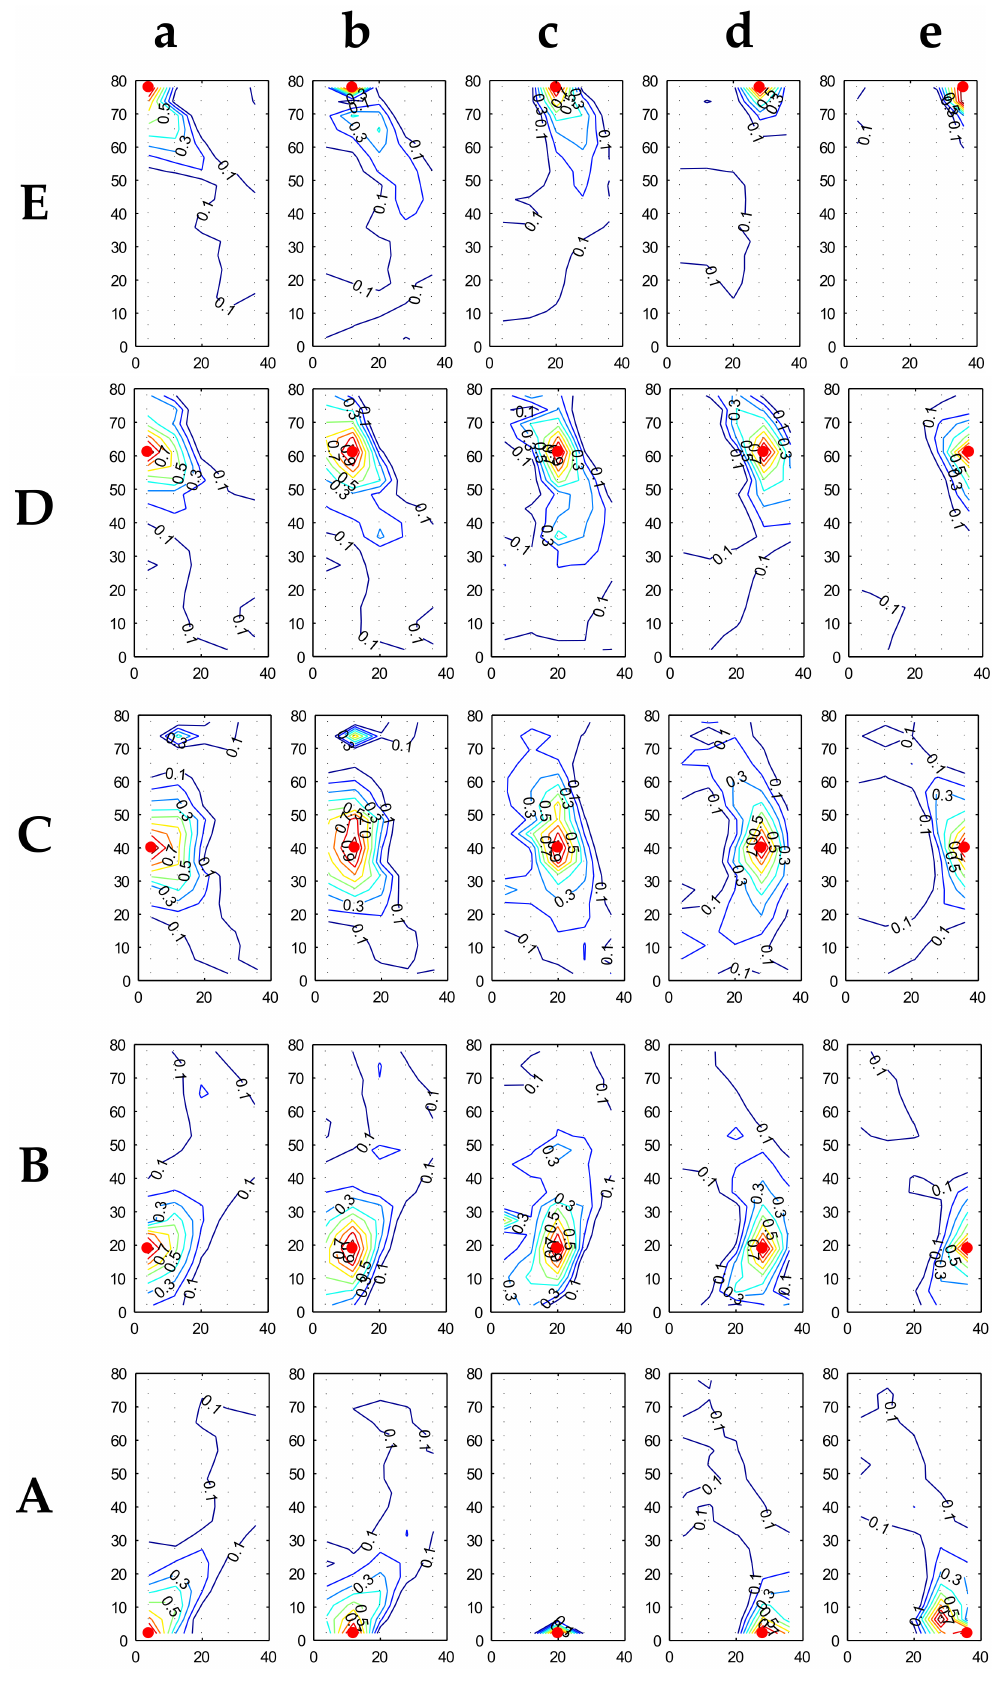
Figure 13. Correlation coefficient trend for RLC at 90 ◦ . Color bar as in Figure